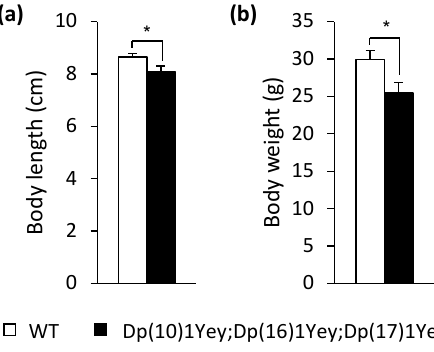
Figure 3. Body length and weight: ( a ) The mean nose-to-anus body length of Dp(10)1Yey;Dp(16)1Yey;Dp(17)1Yey mice was shorter than that of the wild-type control mice ( p = 0.022). ( b ) The mean body weight of Dp(10)1Yey;Dp(16)1Yey;Dp(17)1Yey mice was smaller than that of the wild-type control mice ( p = 0.023). *, p < 0.05.